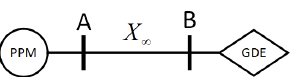
Figure 3. New model for single PPM.